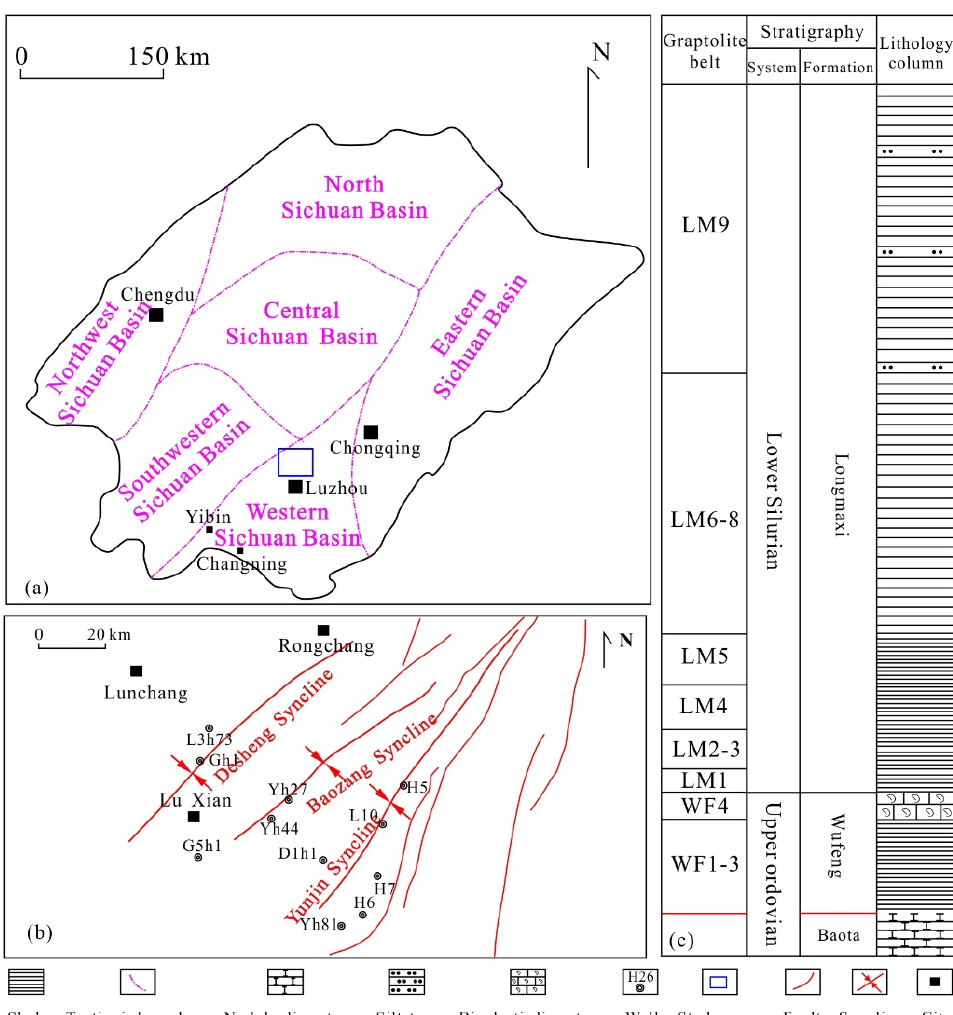
Figure 1. Geological overview of the Sichuan Basin and of the study area: ( a ) tectonic units of the Sichuan Basin (modified from [25]); ( b ) Location of the study area; ( c ) stratigraphic column of the lower Silurian and upper Ordovician.